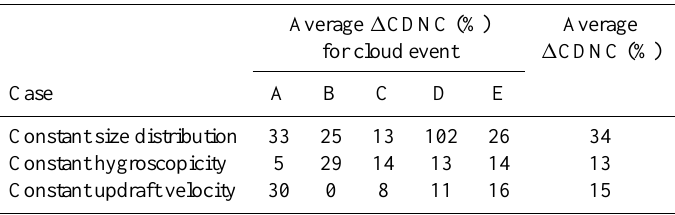
Table 4. The absolute values of the fractional changes in the modeled cloud droplet concentrations, 1 CDNC, in the three sensitivity cases described in Sect. 6.2. The values are given in percents. Also, the average values are given for each cloud event, and the last column indicates the values of 1 CDNC averaged over the whole data